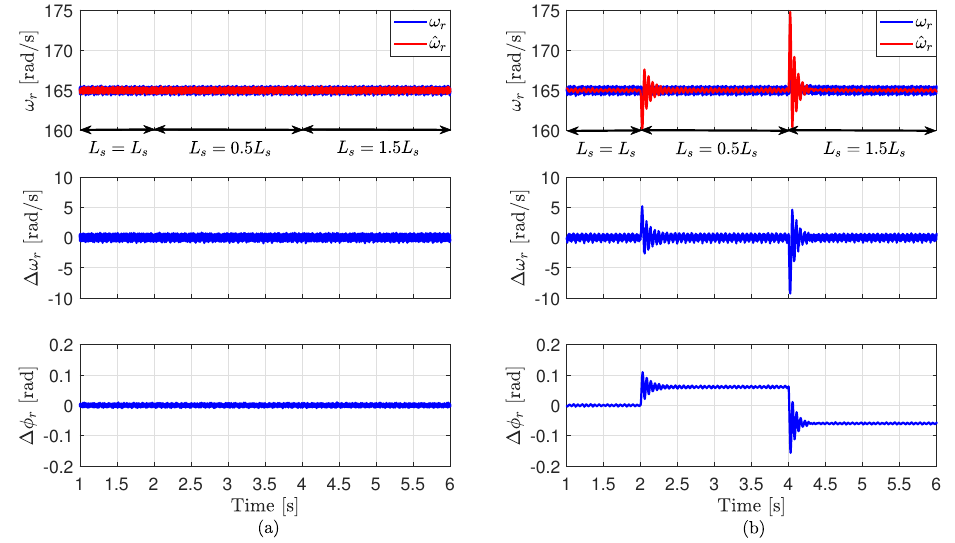
Figure 10. Experimental performance under step changes in the stator inductance L s of the SMPMSG: ( a ) MRAS-FS observer, and ( b ) classical